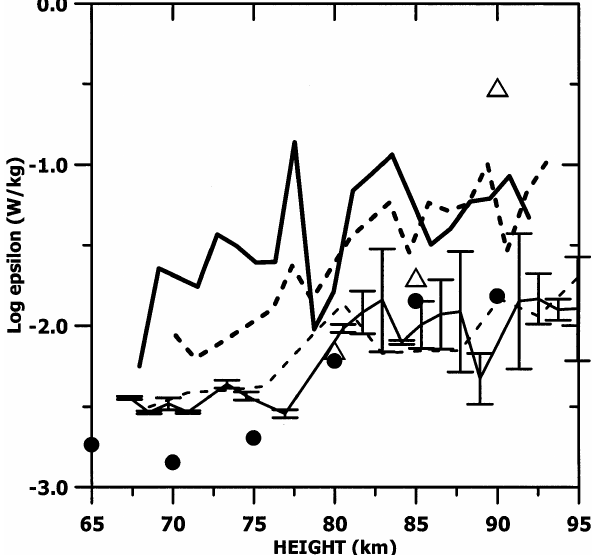
Fig. 5. A comparison of the energy dissipation rates ( ε ) in the meso- sphere over Gadanki with those obtained by others. Thin solid, thin dashed, thick solid and thick dashed lines represent ε over Gadanki for the months of January, April, June and September, respectively. Solid circles and triangles represent ε values reported by Lubken et al. (1993) and Hocking (1990), respectively. Vertical bars show standard errors in ε values over Gadanki in January.